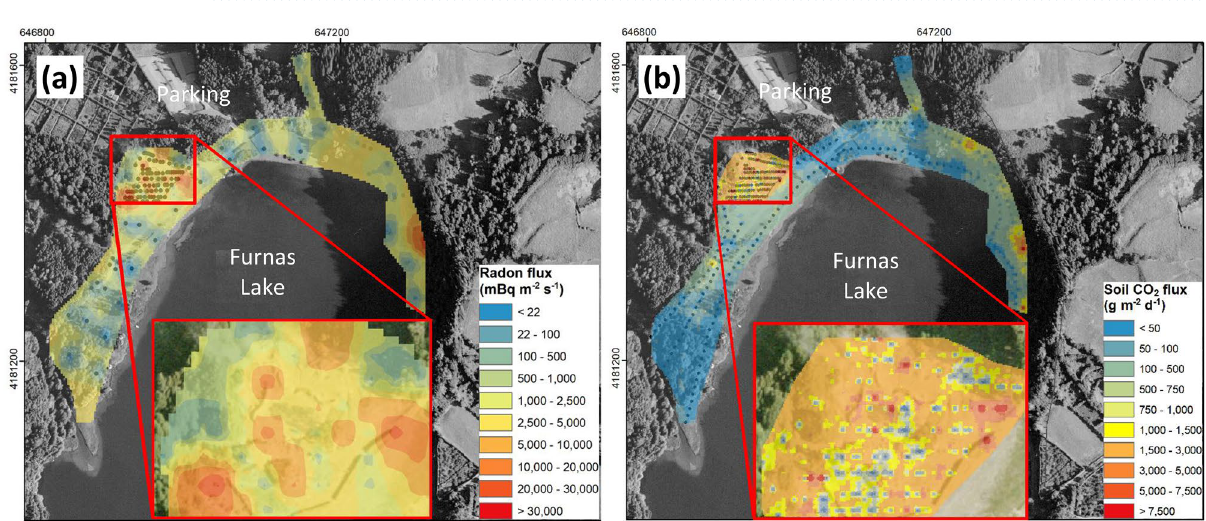
Figure 3. Interpolated (a) radon and (b) CO 2 flux maps of FLFF. For each flux map, the colour scale is shown on the bottom right. In (a,b) , the inset is an enlargement of the fumarolic area. The map is projected following the UTM coordinate system. The map was built using sGs method with a cell size of 3 m 2 (see “Methods”